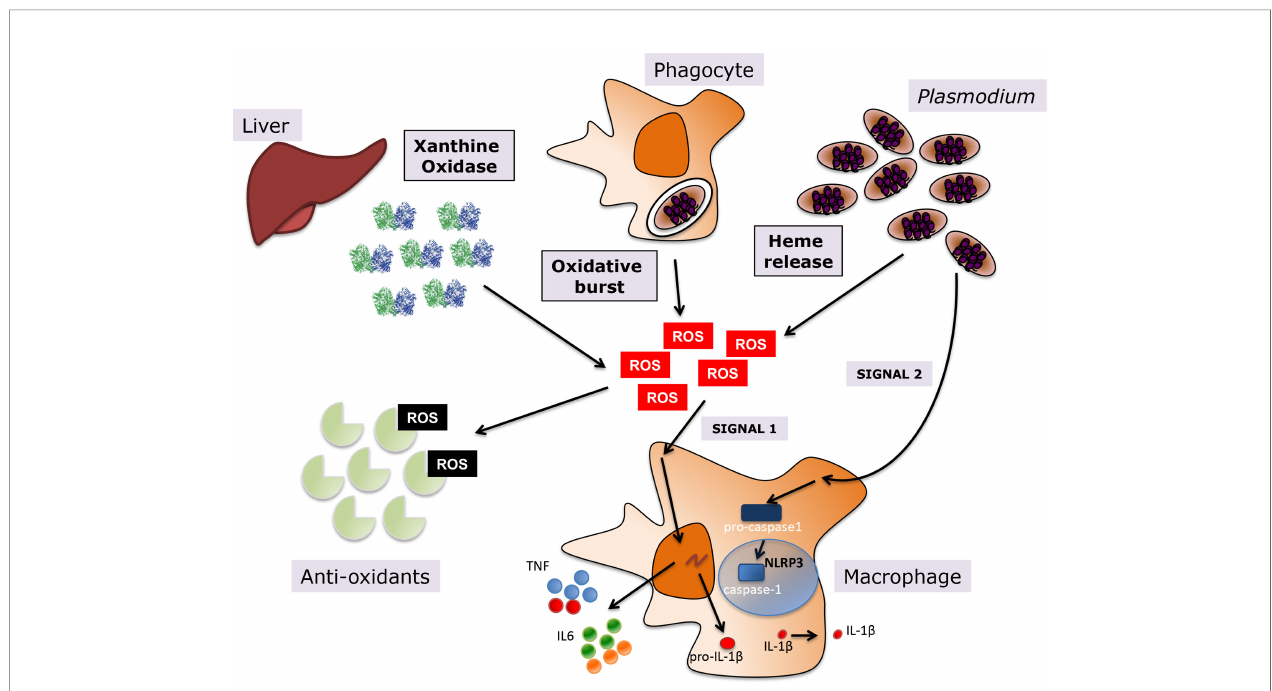
FIGURE 1 | Oxidative stress during Plasmodium infection. Various sources contribute to the oxidative environment during malaria, including upregulation of host enzymes such as XO, the oxidative burst in macrophages upon phagocytosis of infected erythrocytes, and heme release from hemoglobin degradation in host infected erythrocytes. A balance between levels of anti-oxidants in the human host and the generation of ROS determines the levels of oxidative stress. ROS promote in fl ammation in malaria, leading to the activation of macrophages and the subsequent release of pro-in fl ammatory cytokines, such as TNF and IL6 among others, but also in fl ammasome-dependent IL1- b , where ROS provide priming signal 1 and P. falciparum the activating signal